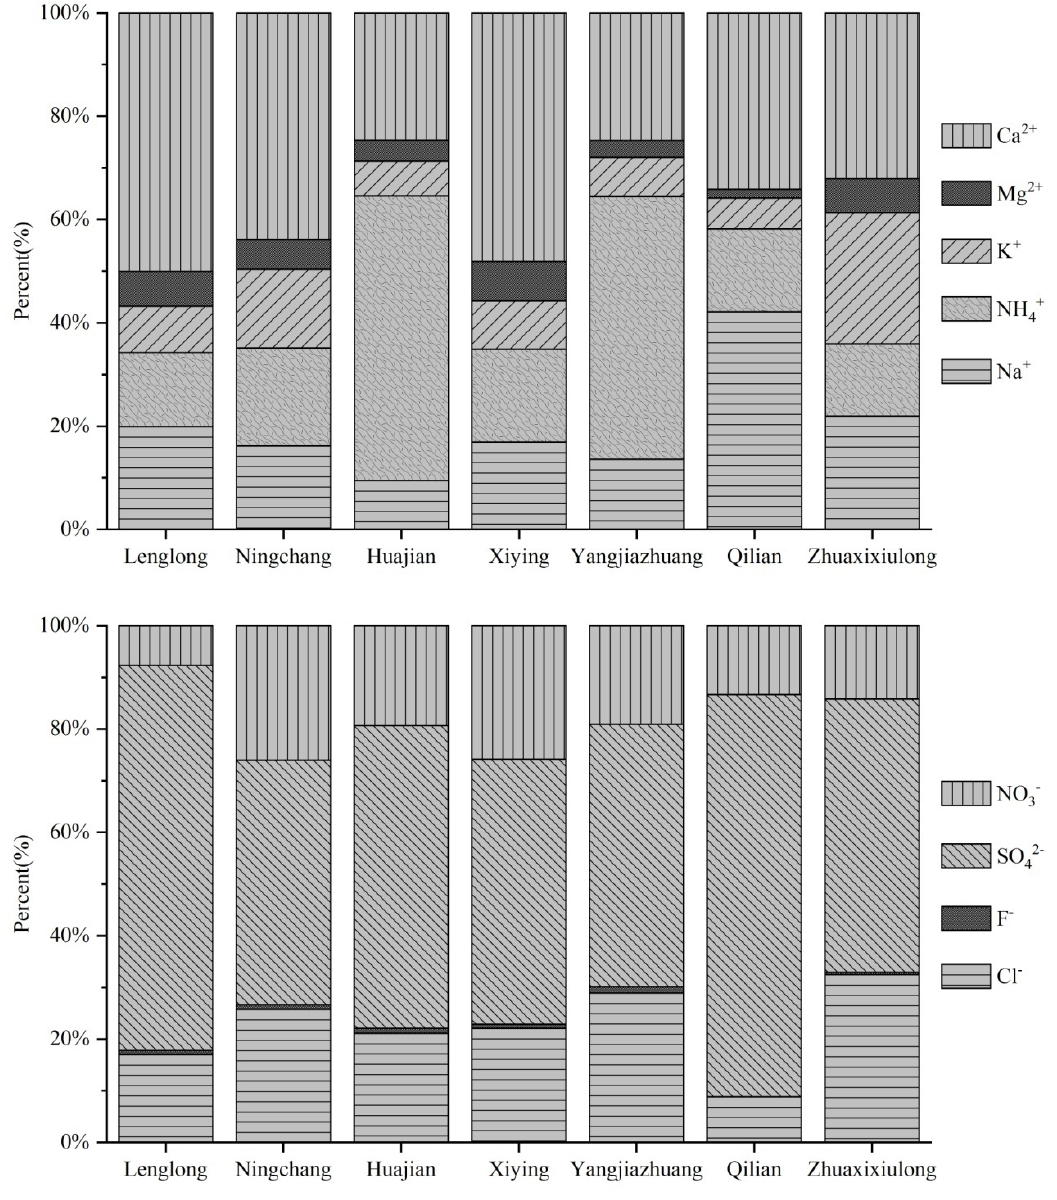
Figure 9. Percentage accumulation diagram of the ion concentration in the precipitation.